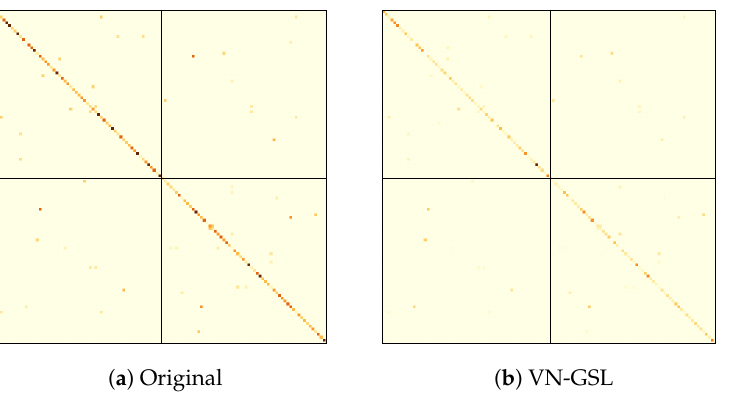
Figure 4. The adjacency matrix heatmap (with two categories of 60 nodes each extracted from the Cora dataset) ( a ) the original graph with self-loops on the Cora dataset, and ( b ) the graph learned by our method on the Cora dataset. The darker blocks represent a greater edge weight between the two